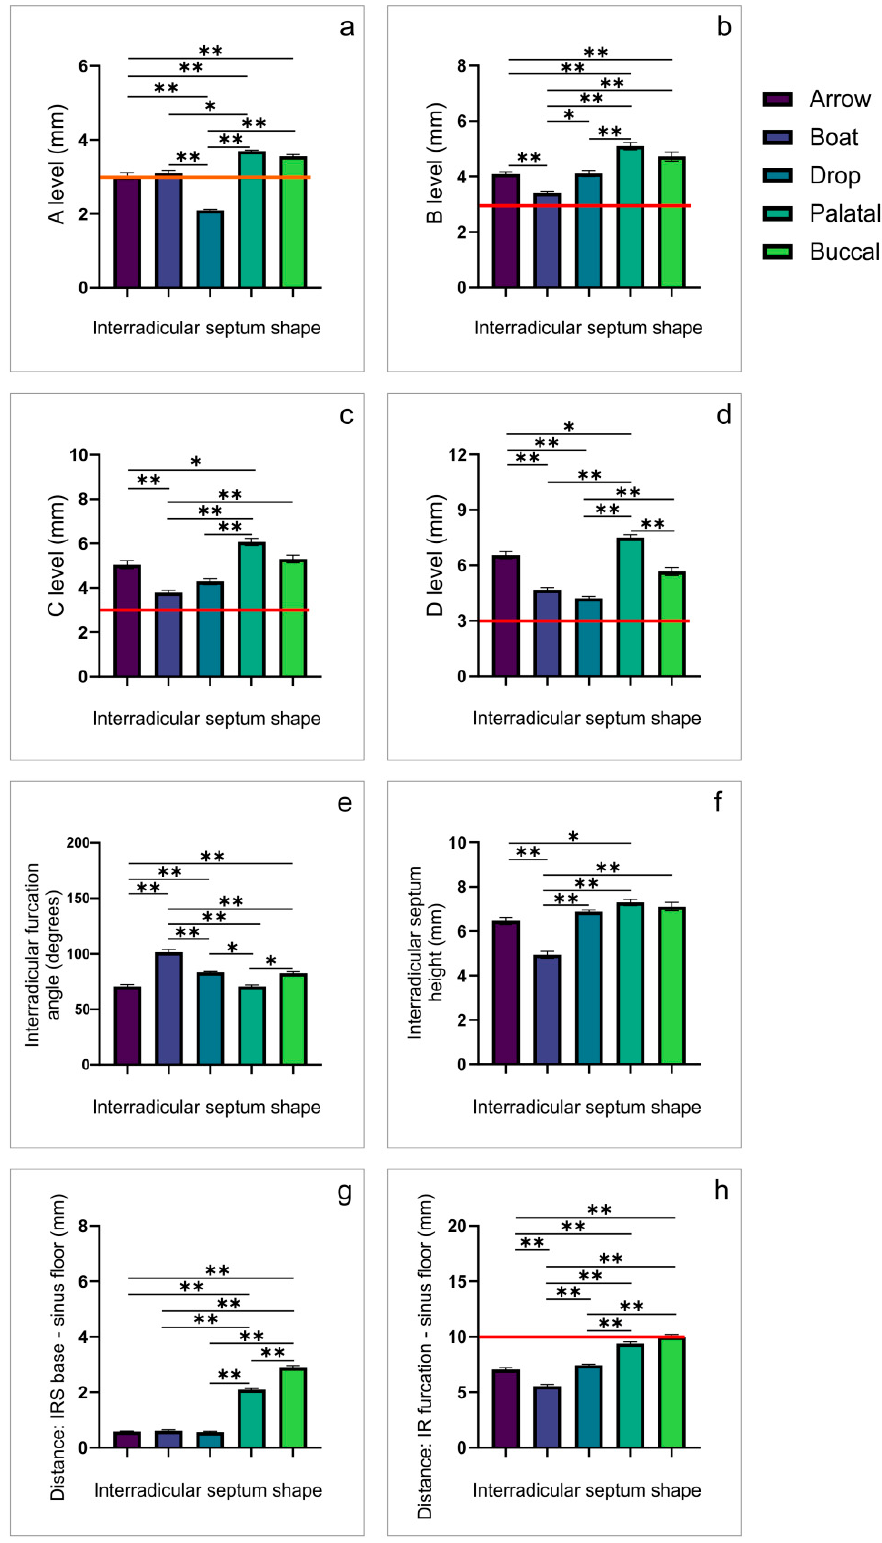
Figure 3. The observed differences in IRS morphometric parameters according to the IRS shape for the first maxillary molars obtained in the coronal CBCT views (the margin of clinical importance).